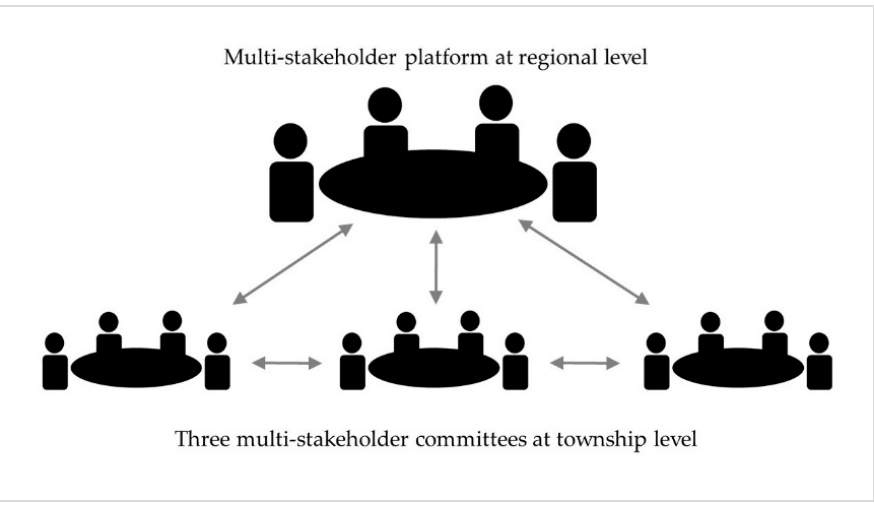
Figure 1. Overview of the regional-level multi-stakeholder platform and the township-level committees.